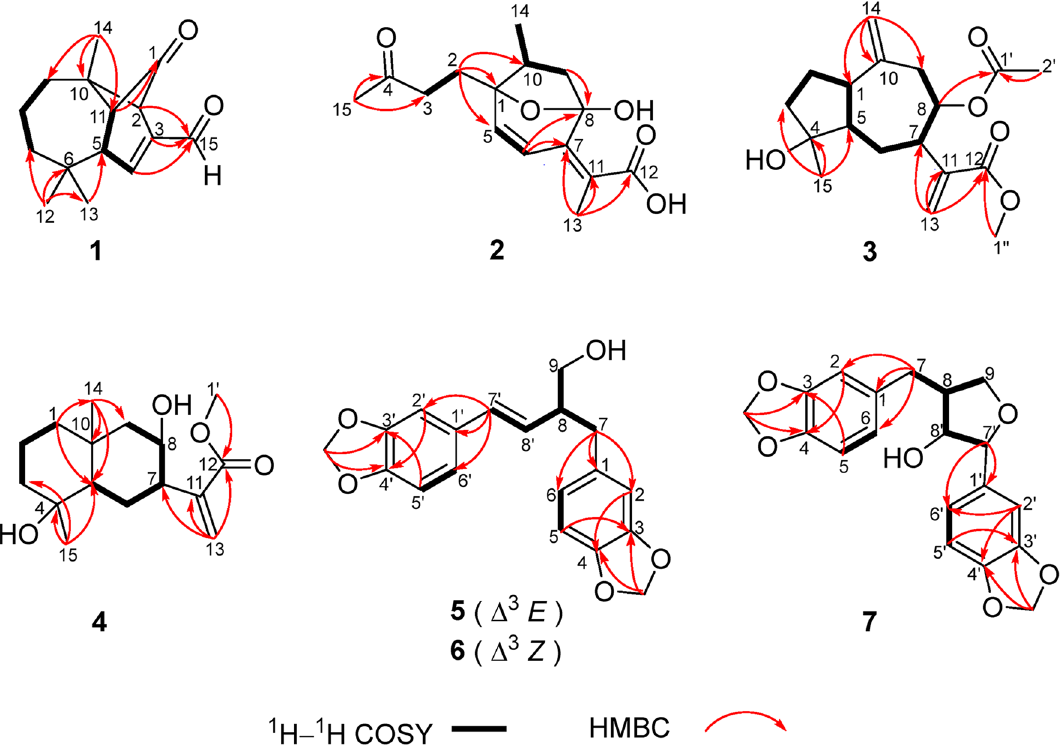
Fig. 2 Key 1 H– 1 H COSY and HMBC correlations of compounds 1 –